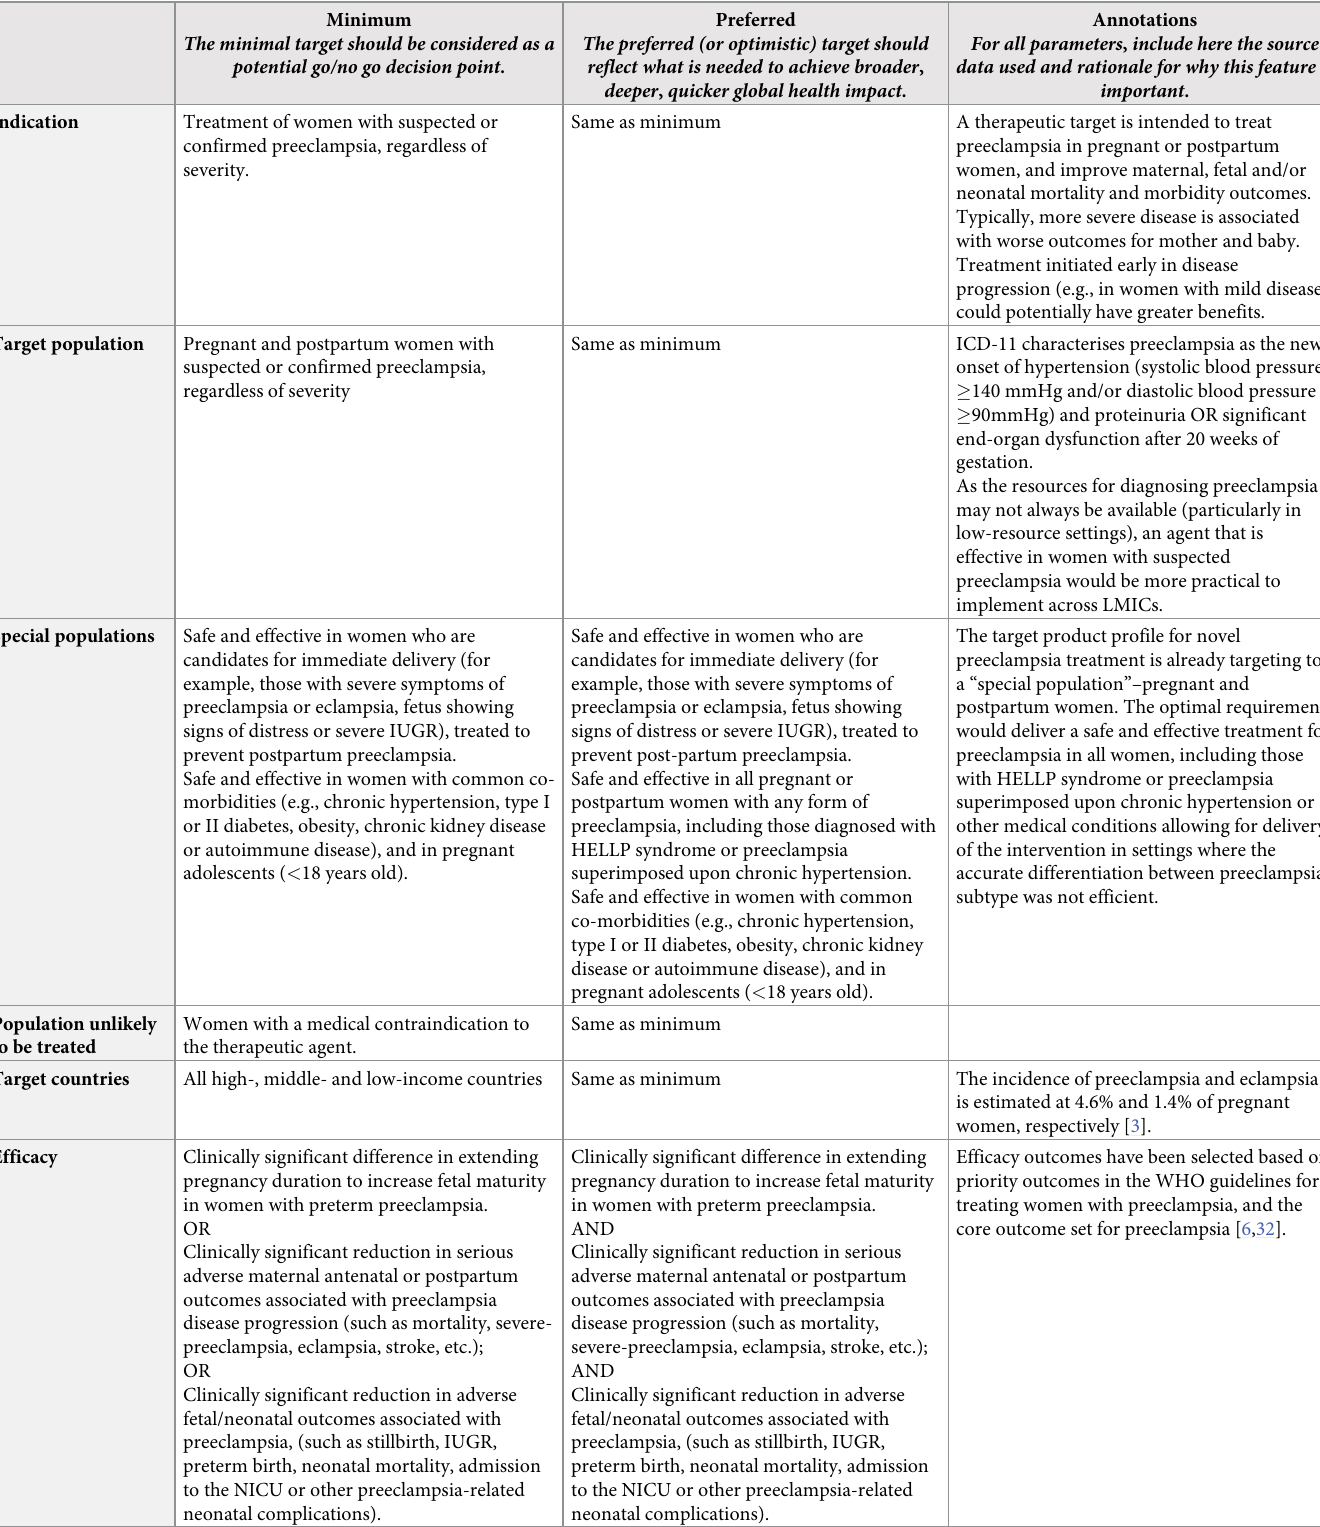
Table 2. Target product profile for medicines to treat